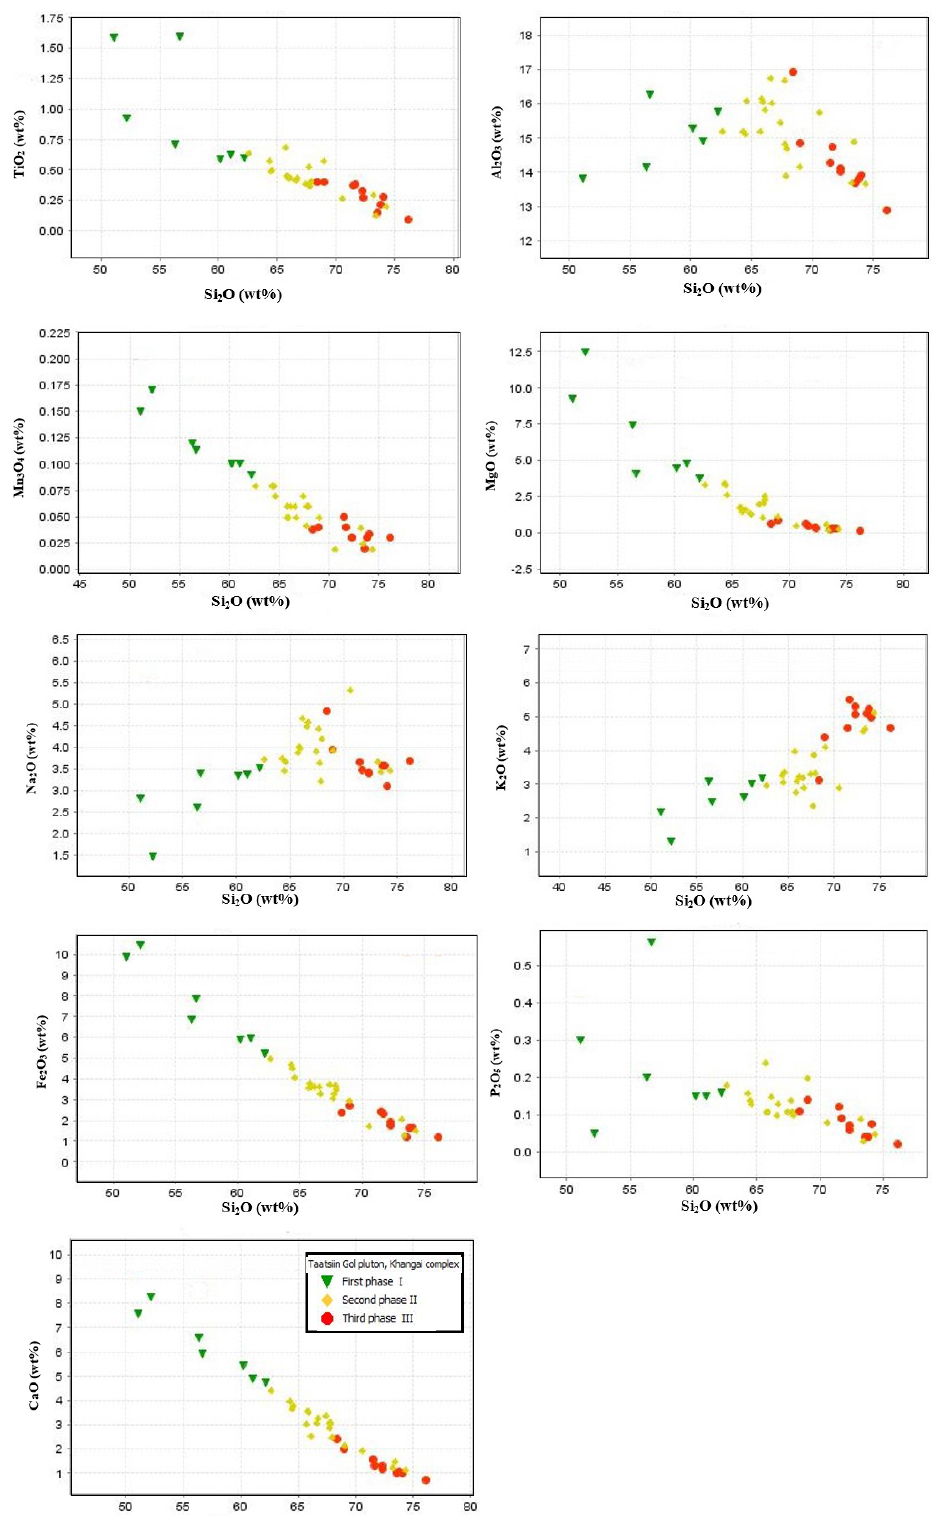
Fig. 11. Harker variation diagram for the Taatsiin Gol